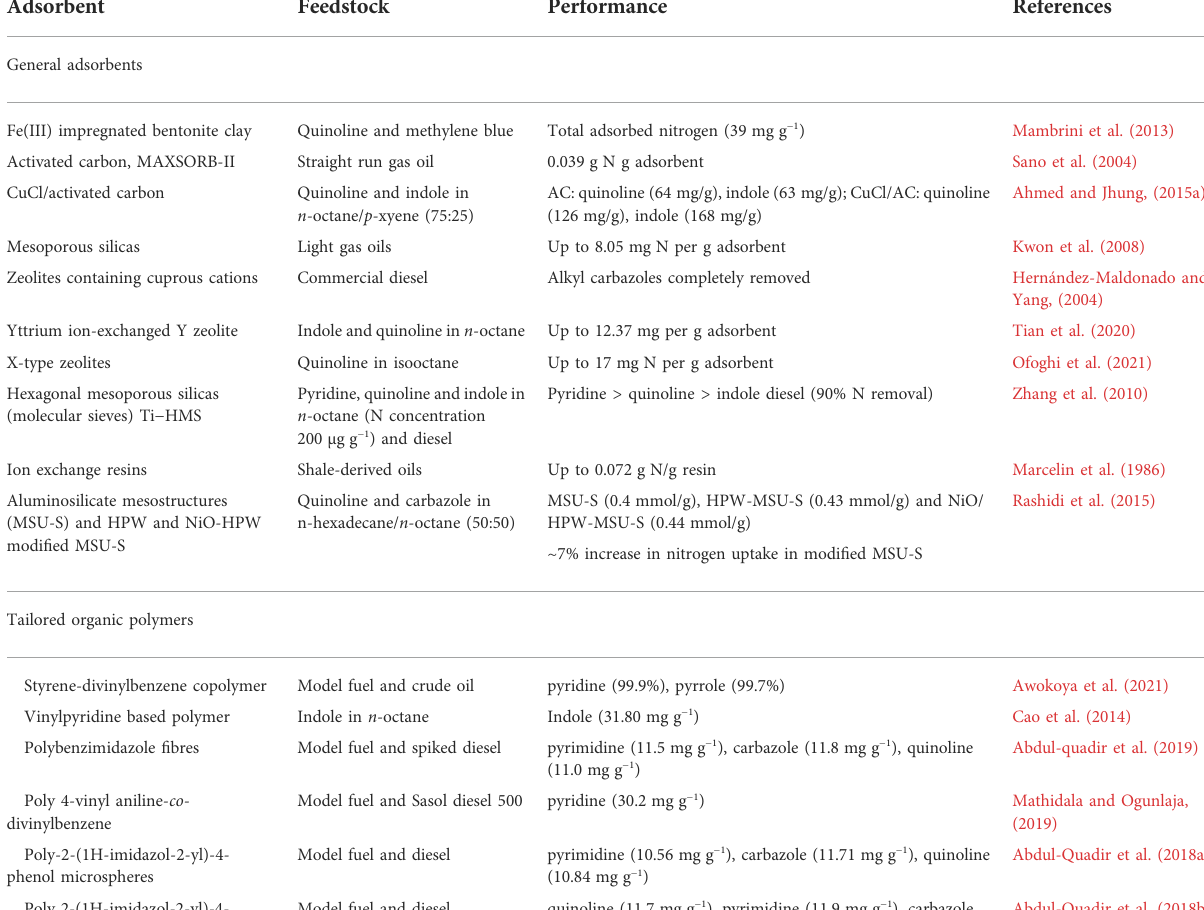
TABLE 3 Typical examples of adsorbents that have been tested for adsorptive